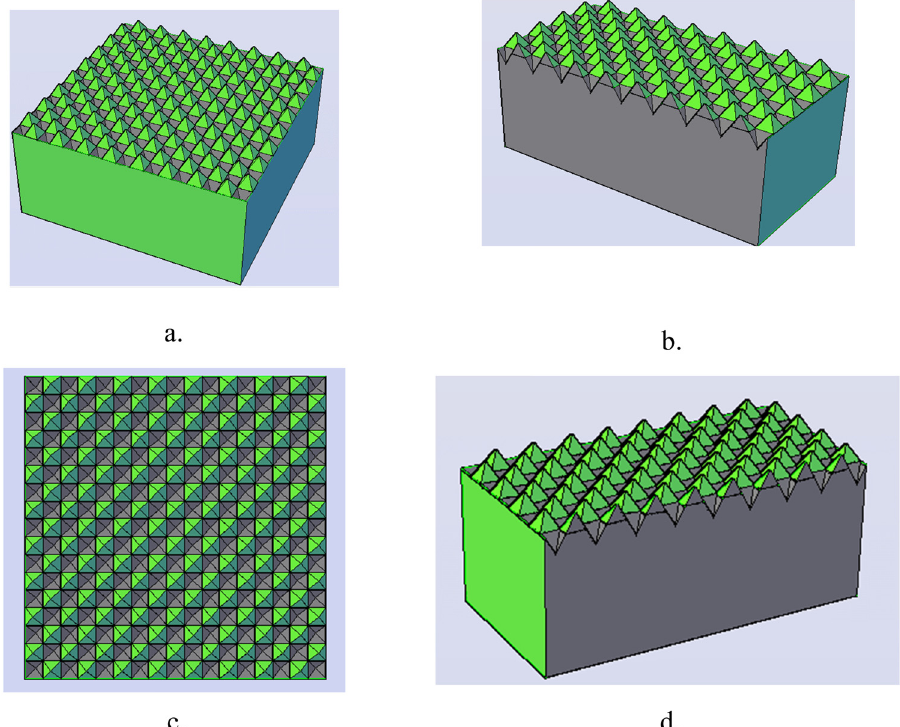
Figure 5: 3D zigzag model. ( a ) Model side view. ( b ) Transverse cutting view. ( c ) Model bird ’ s - eye view. ( d ) Longitudinal cutting view.